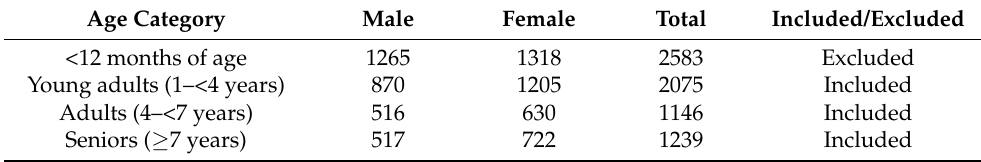
Table 2. Summary of the signalment of 8628 cats rehomed from Wood Green, The Animals Charity between November 2011 and May 2016, including the 4460 cats analysed for the study. In addition to the 2583 kittens excluded from the study, 1291 cats were excluded due to having no recorded adoption profile and 294 cats were excluded for not having a recorded date of